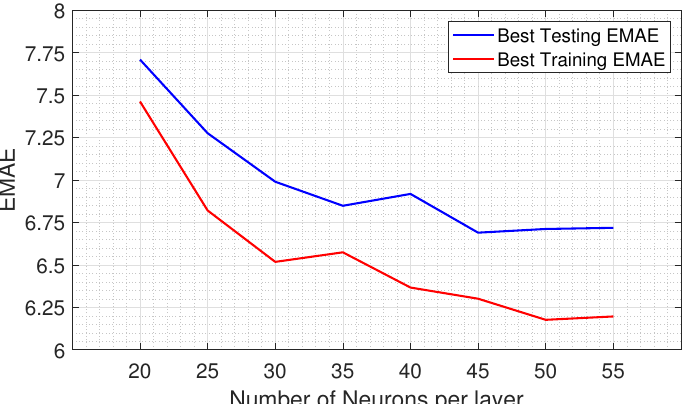
Figure 3. Evolution of the EMAE on the training (red line) and testing (blue line) datasets as the number of neurons in each hidden layer increased. Two identical layers were considered and the number of neurons ranged from 20 to 55 per